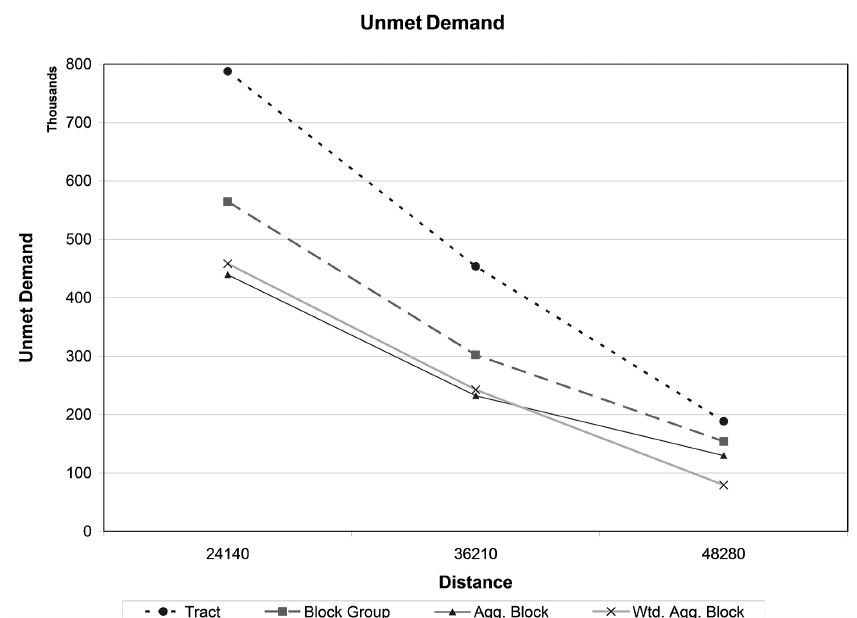
Fig. 10. Results of the models run with four representations of demand. The distances on the horizontal axis represent the equivalents (in meters) of 30, 45, and 60 minute driving time